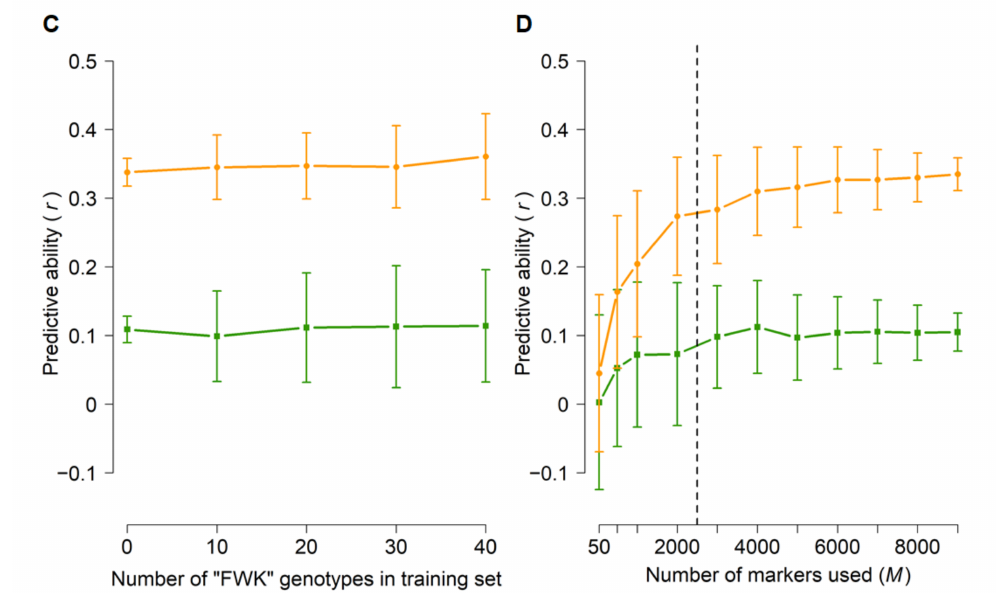
Figure 6. Genomic predictive ability within families. GBLUP predictive ability for diameter at breast height (DBH) and wood density (WD) as a function of the number of “QTL” or “FWK” genotypes included in the training set ( A , C ) and the number of markers ( B , D ) used in cross-validations. Error bars correspond to standard deviations across 100 iterations for each set of parameters. For analyses in ( A , C ), a training set of 1600 genotypes (including the desired number of “QTL” or “FWK” genotypes) was randomly sampled, and all 9353 markers were used. The training set in ( B , D ) was selected at random ( N = 1600), with no “QTL” or “FWK” genotypes included, and subsets of markers were selected at random. All predictive abilities were only for “QTL” or “FWK” genotypes that were not included in the training set ( N = 41–86, see Materials and Methods and Table 1). The dashed lines in ( B , D ) indicate the plateaus in predictive